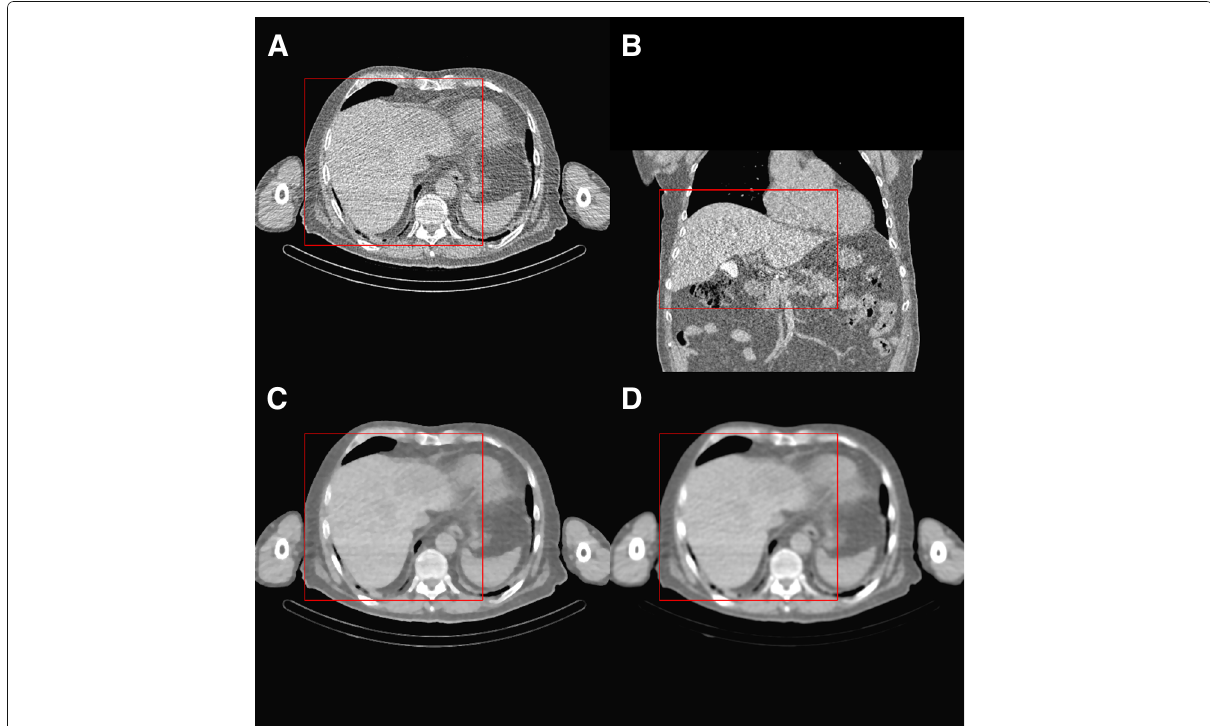
Fig. 2 Patient ID BI01 from training set in our database: a , b transaxial and coronal view of a CT MAA , c , d median filter and Gaussian filter (fwhm = 4) of the same slide in transaxial slice (image c is sharper and voxels within the liver are more homogeneous; red contours show the boxes that are defined for data